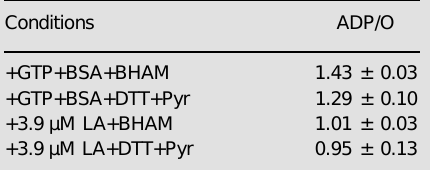
Table 1 - Effect of various incubation conditions on the ADP/O